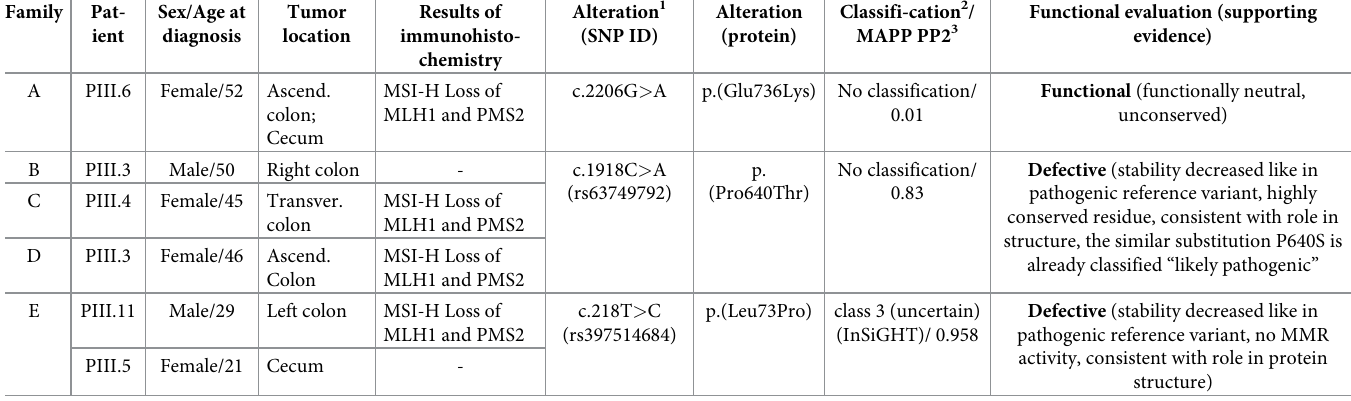
Table 1. Clinical and genetic information of the investigated Tunisian patients and functional variant